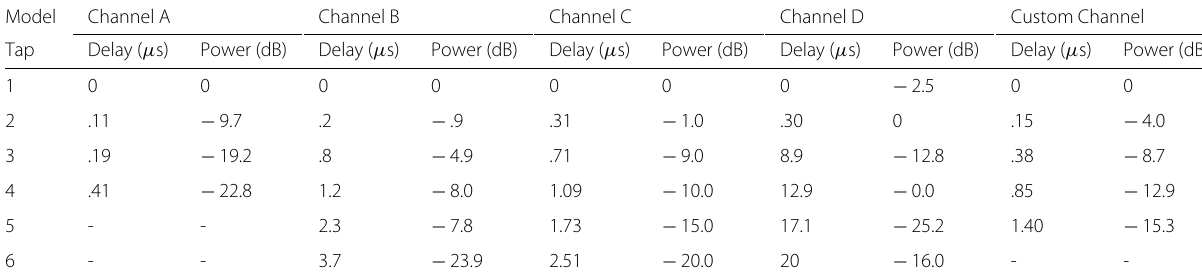
Table 2 Power delay profiles of the channel models used on the emulator Model Channel A Channel B Channel C Channel D Custom Channel Tap